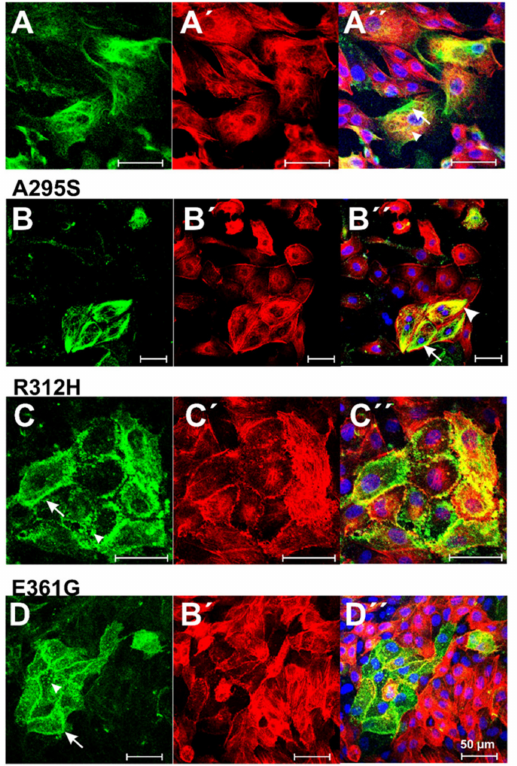
Figure 5. Transfection of MDCK cells with HA-tagged c-actin variants. The MDCK cells were trans- fected with vectors containing HA-tagged c-actin variants (for details, see Materials and Methods). Subsequently, the cells were immunostained with anti-HA and counterstained with TRITC-phalloidin. ( A ) wt c-actin stained with anti-HA (green); ( A’ ) TRITC-phalloidin staining;. ( B – B’ ) p.A295S mutant; ( C – C’ ) p.R312H mutant; and ( D – D’ ) p.E361G mutant; all with identical staining procedure. Note for WT and p.A295S mutant c-actins the preferential incorporation in the stress fiber system, whereas p.R312H and p.E361G mutants showed a more circumferential anti-HA staining suggesting preferred incorporation into short cortical actin filaments. ( A” – D” ) give merged images including nuclear stain by Hoechst 33342 not shown separatly. Bars: 20 µ